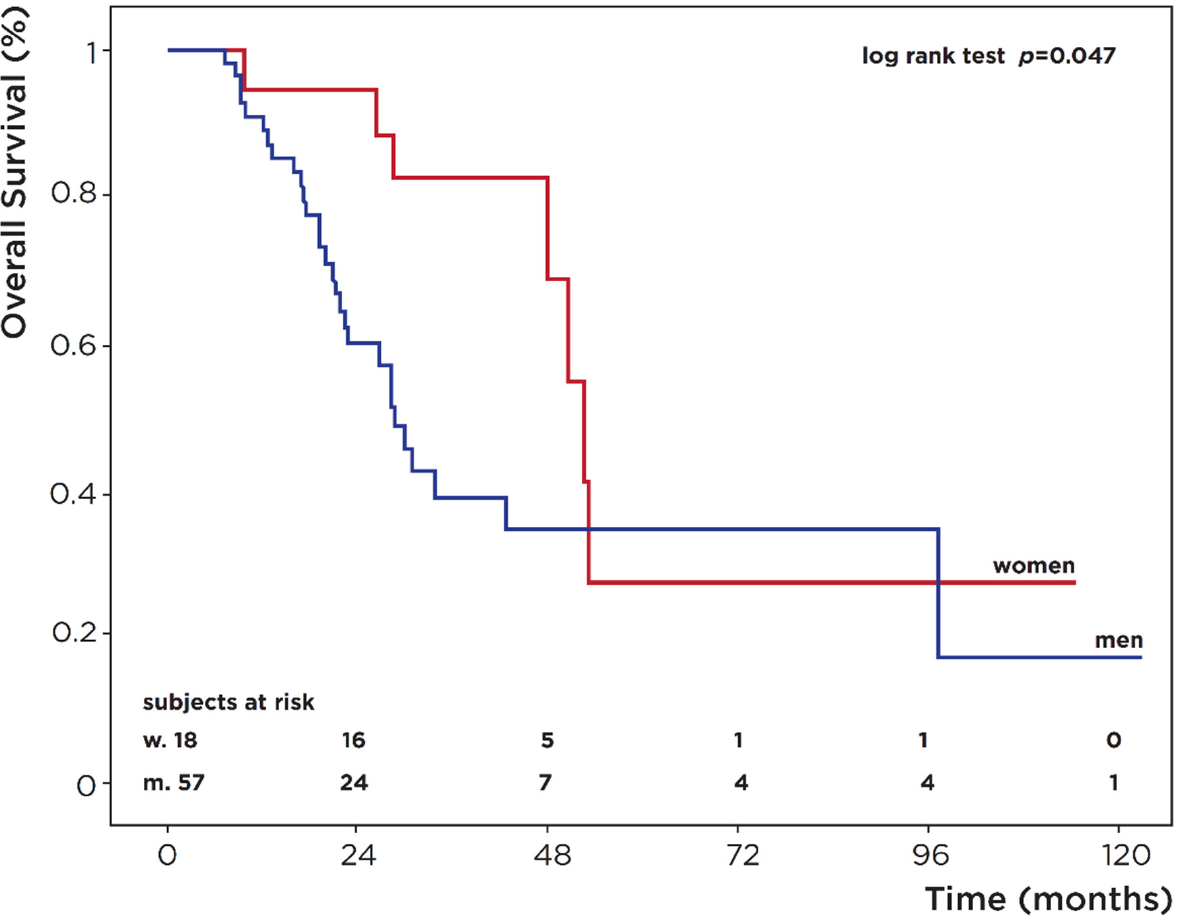
Figure 1. Overall survival (OS) in patients with advanced urothelial cancer.